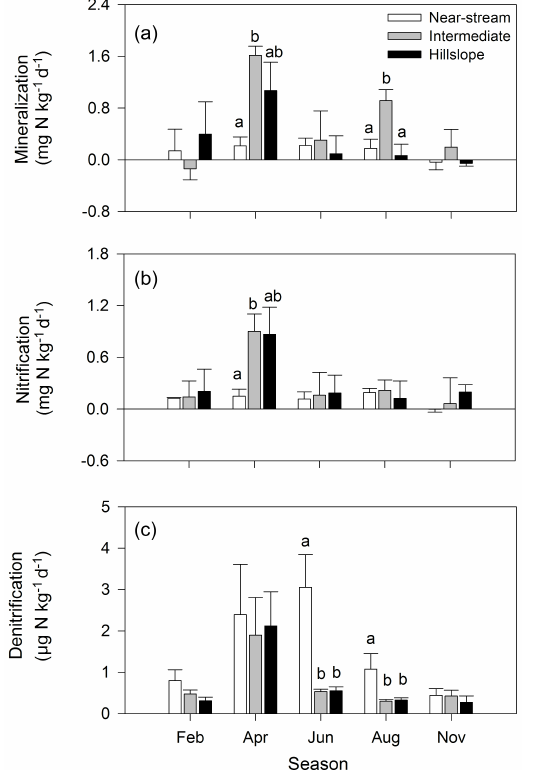
Figure 4. Temporal pattern of (a) soil net N mineralization, (b) net nitrification, and (c) denitrification rates at the near-stream (white), intermediate (grey), and hillslope (black) zones during the study period. Bars are mean values for each section and error bars are standard errors. For each season, different letters indicate significant differences among sections (mixed-model ANOVA, p < 0 . 05).